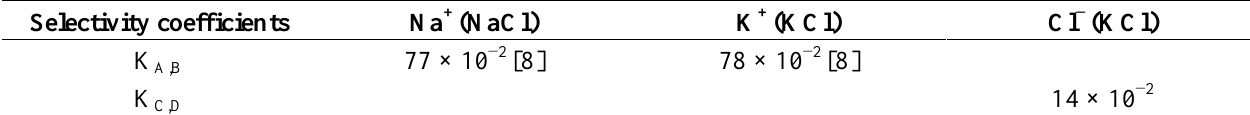
Table 2. Selectivity coefficients of various interfering